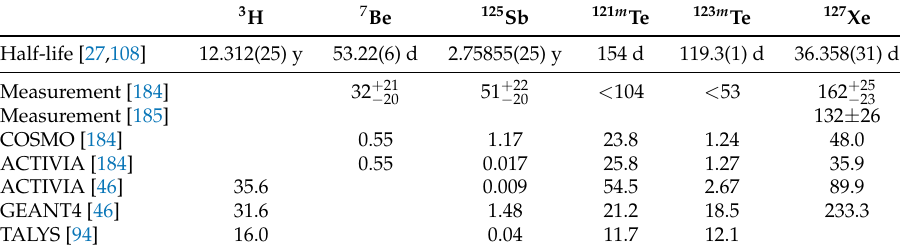
Table 4. Rates of production of long-lived radioisotopes induced in natural xenon at sea level. Measurements from Refs. [184,185] and different calculations are presented (see text). All numbers are expressed in